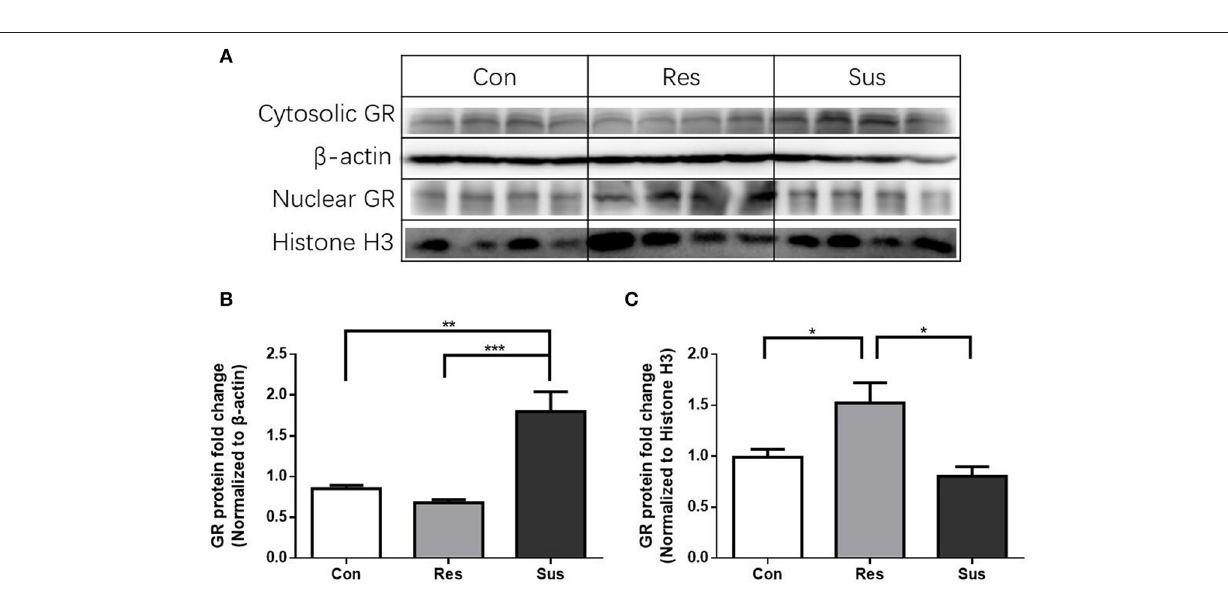
FIGURE 7 | More nuclear translocation of GR in the hippocampus was found in resilient mice than susceptible mice after chronic social defeat stress. (A) Representative western blots showing cytosolic and nuclear protein expression of GR. (B) Quantification of cytosolic protein expression of GR in the hippocampus after chronic social defeat stress ( n = 4/group). (C) Quantification of nuclear protein expression of GR in the hippocampus after chronic social defeat stress ( n = 4/group). All data are shown as mean ± s.e.m. * P < 0.05, ** P < 0.01, *** P < 0.001. Con, Control; Res, Resilient; Sus,